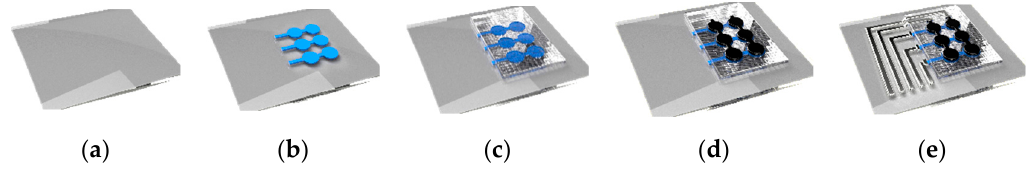
Figure 1. Illustration of the manufacturing process flow of printed ferroelectric sensor arrays based on polyvinylidene fluoride-trifluoroethylene P(VDF-TrFE) repeated units (reprinted with permission from JOANNEUM RESEARCH (JNR)). ( a ) Substrate; ( b ) Bottom Electrodes; ( c ) Active sensors based on P(VDF-TrFE) film + Top electrodes (1); ( d ) Top electrodes (2); ( e ) Connecting